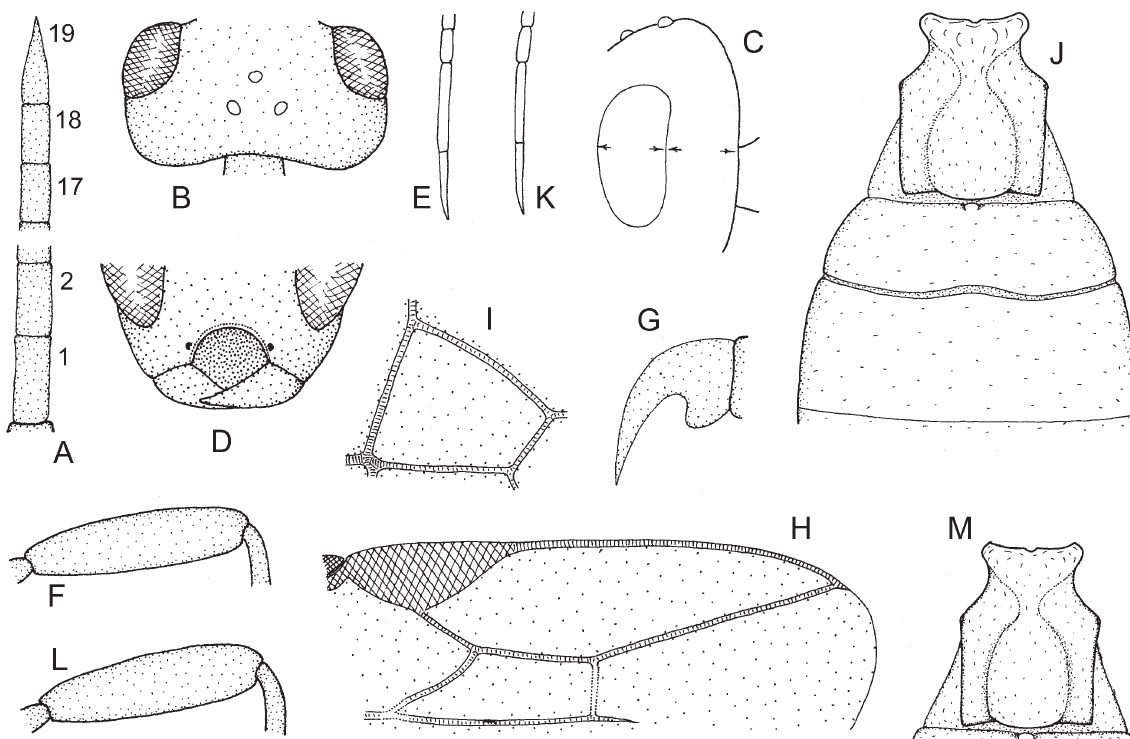
Fig. 54. Bracon ( Palpibracon ) delibator Haliday, 1833 (A-J: ♀ neotype, K-M: ♀). A . Flagellomeres 1-2 and 17-19. B . Head in dorsal view. C . Head in lateral view. D . Head in frontal view. E . Ultimate three segments of maxillar palp. F . Hind femur. G . Claw. H . Distal part of right forewing. I . First discal cell of right forewing. J . Tergites 1-3. K . Ultimate three segments of maxillar palp (♀ / ♂). L . Hind femur. M . First